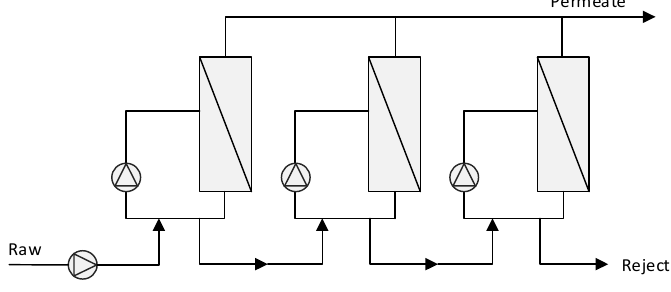
Figure 3. Continuous process with internal circulation.